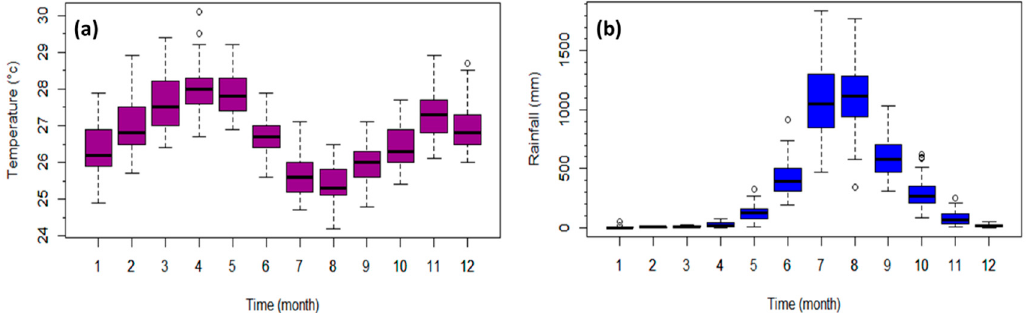
Figure 4. Climatology of monthly temperature showing two picks on April and November ( a ) and monthly rainfall showing a pick on July ( b ) as derived from ground observations at Conakry station from 1960 to 2016.